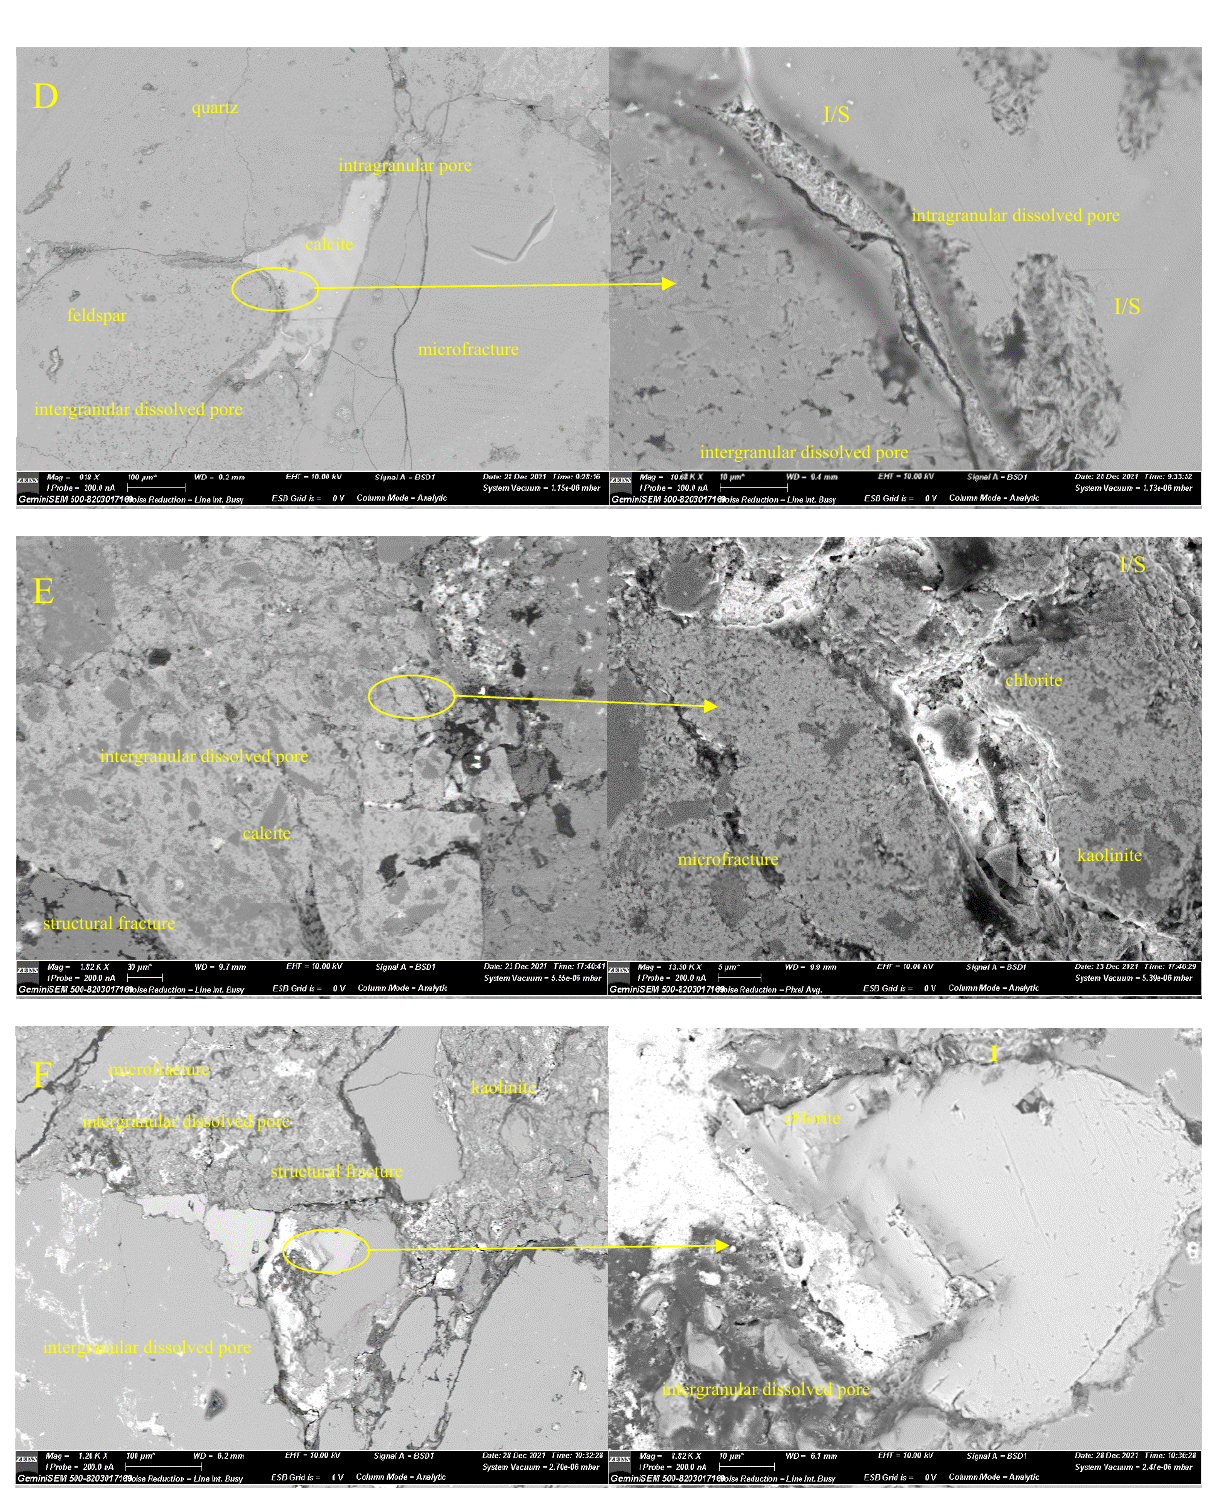
Figure 5. SEM images of samples from the Mahu tight reservoirs showing the relationships between the pore throats and clay minerals. ( A ) M136, conglomerate with small pebbles, 3295.1 m; ( B ) M131, sandy conglomerate, 3188.2 m; ( C ) M604, conglomerate with medium pebbles, 3782.6 m; ( D ) M136, pebbly sandstone, 3298.1 m; ( E ) M602, fine-grained conglomerate, 3882.6 m; ( F ) M604, fine-grained conglomerate, 3769.4 m.